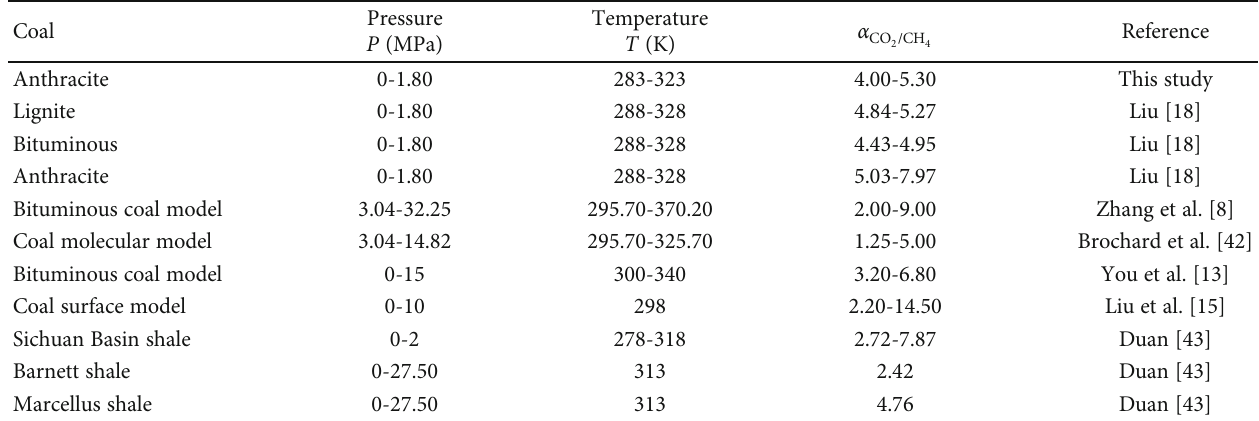
over CH at three temperatures for the adsorption of di ff erent CO 2 4 = 0 : 9 . CO 2 ff erent coals and CO 2 /CH 4 on di